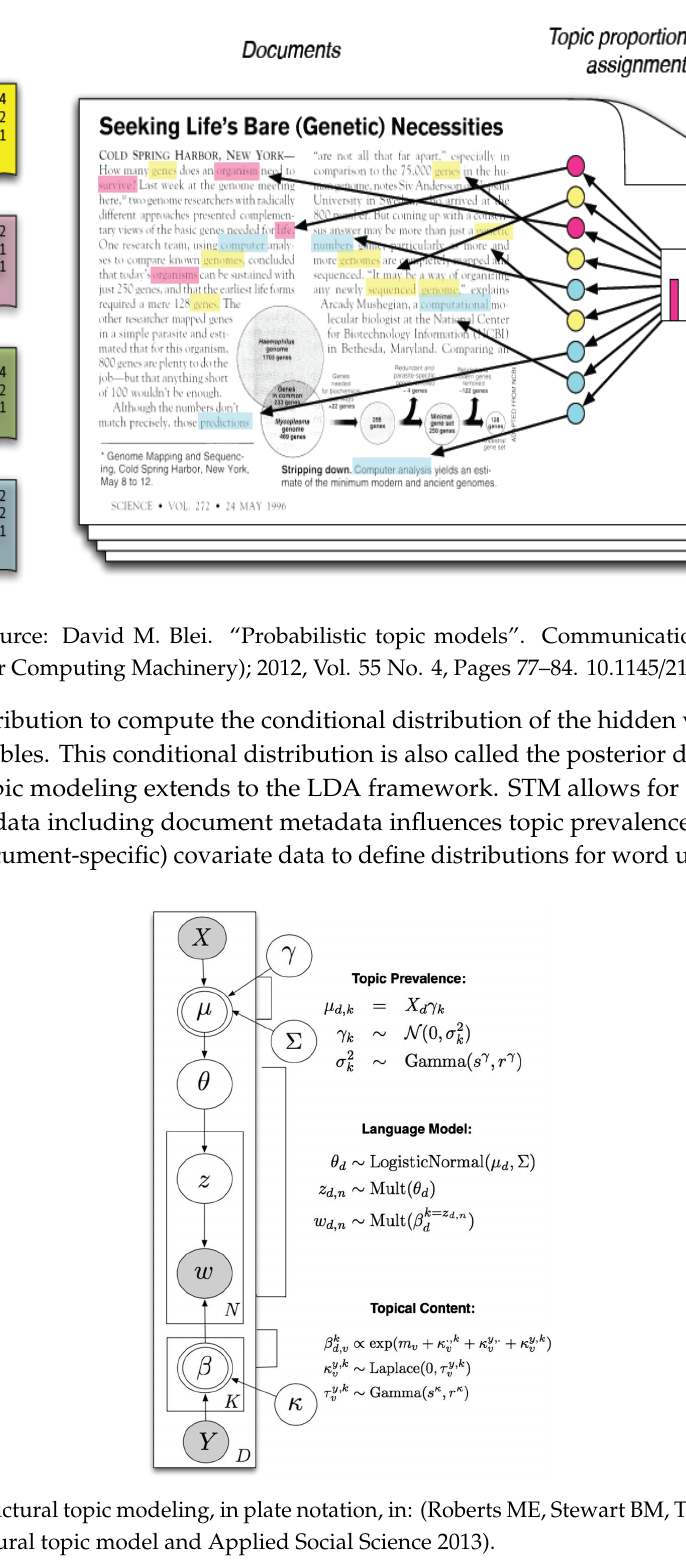
Figure A2. Structural topic modeling, in plate notation, in: (Roberts ME, Stewart BM, Tingley D, Airoldi EM. The structural topic model and Applied Social Science 2013).